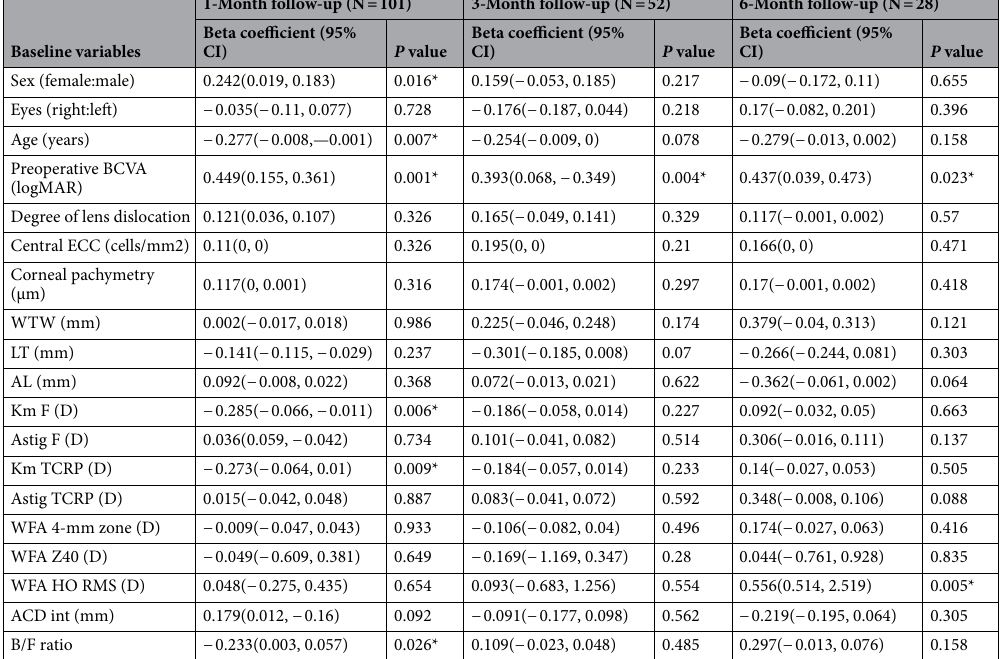
Table 3. Univariate analysis of factors associated with BCVA of the post-operative MFS group. BCVA: best- corrected visual acuity; ECC: endothelial cell count; WTW: white to white; LT: lens thickness; AL: Axial length; Km: mean keratometry; F: front (anterior corneal surface); Astig: astigmatism; TCRP: total corneal refractive power; WFA 4-mm zone: wave front aberration in the 4-mm zone around the corneal apex; WFA Z40: total corneal spherical aberrations (Z4,0) in the 6-mm zone around the corneal apex; WFA HO RMS: root mean square of the total corneal high order aberrations calculated in the 4-mm zone around the corneal apex; B/F ratio: mean radius of the posterior corneal surface/mean radius of the anterior corneal surface ratio; ACD: anterior chamber depth; Cornea: corneal diameter (horizontal).